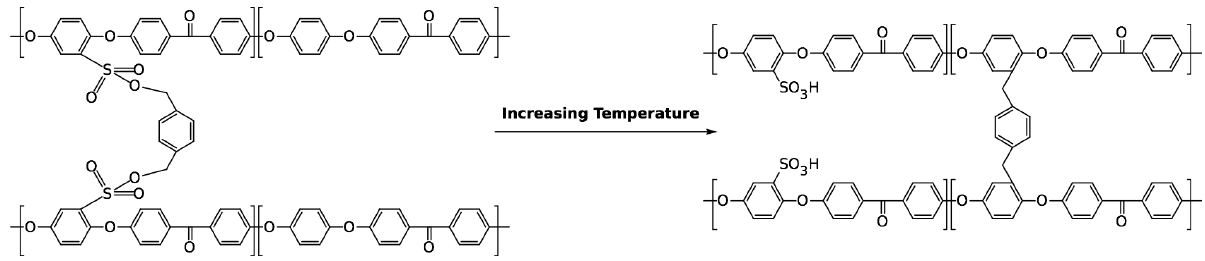
Figure 11. Crosslinking positions of the 1,4 Benzyl-di-methanol.